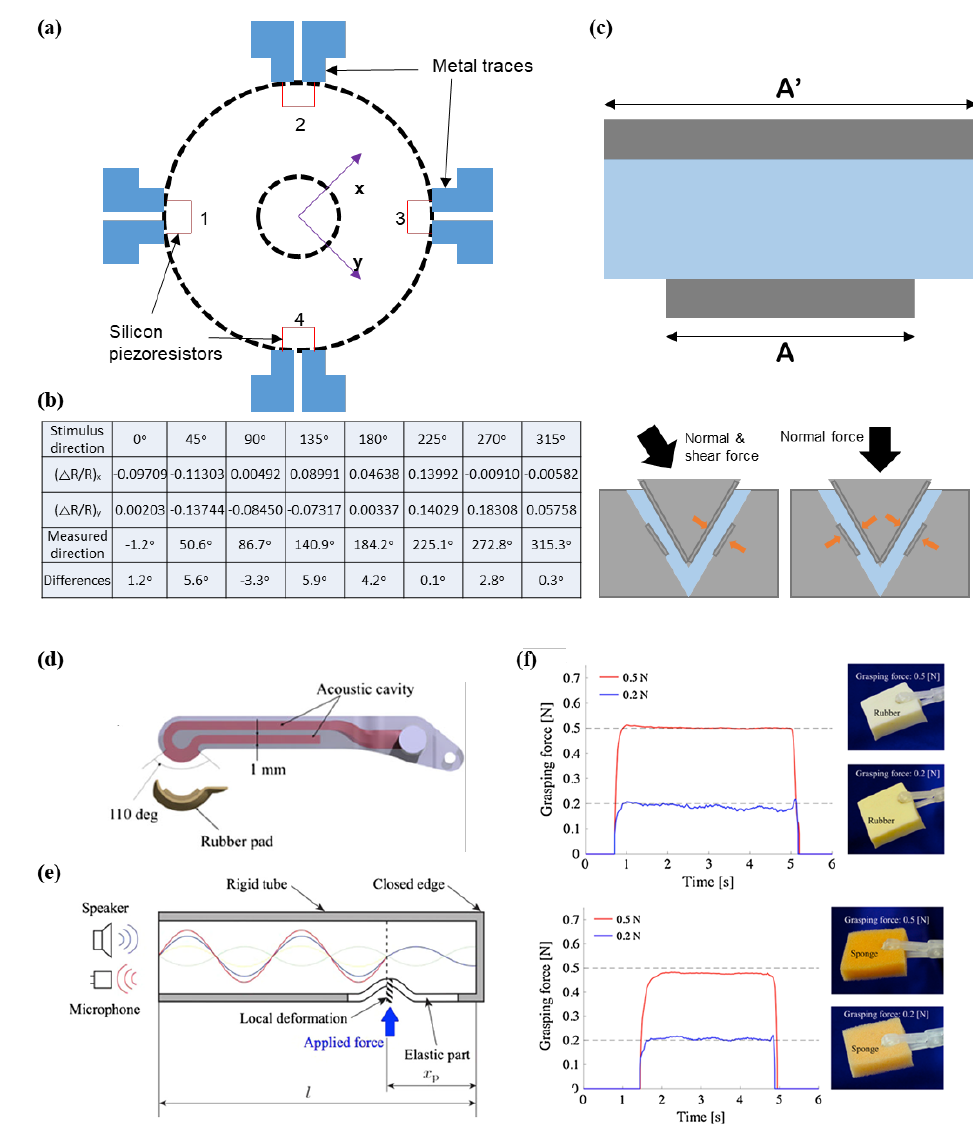
Figure 19. ( a ) Picture of the structure of bio-inspired tactile sensor; ( b ) table indicating data of the scratching test from different force directions measured by the bio-inspired tactile sensor; ( c ) image of the proposed capacitance architecture to measure a three-axis force (top). Illustration demonstrates the sensing mechanism corresponding to normal and shear force (bottom); ( d ) image showing the upper area of forcep with the acoustic cavity; ( e ) diagram indicates the sensing principle of the acoustic tactile sensor; ( f ) experimental data from the acoustic tactile sensor, when grasping the materials, including rubber and sponge (reprinted with permission for Figure 19d–f from Ref. [176] Copyright 2017 Springer Nature).